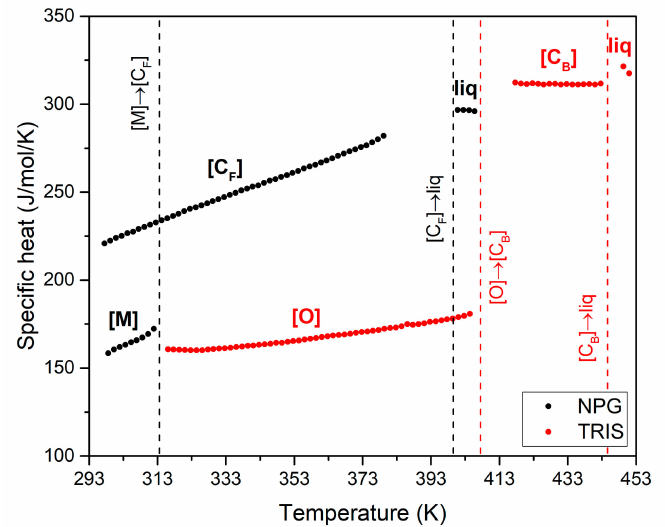
Figure 2. Measured values of specific heat for pure NPG (black) and TRIS (red).